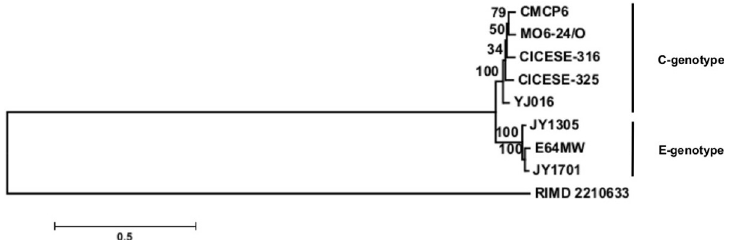
Fig 1. Phylogenetic tree of V . vulnificus C-genotype and E-genotype strains, using V . parahaemolyticus RIMD 2210633 genome as out-group. Bootstrap values for each node are indicated in the tree. Analysis was implemented with SNP using the maximum likelihood method (Kimura 2-parameters model), with 1000 bootstraps